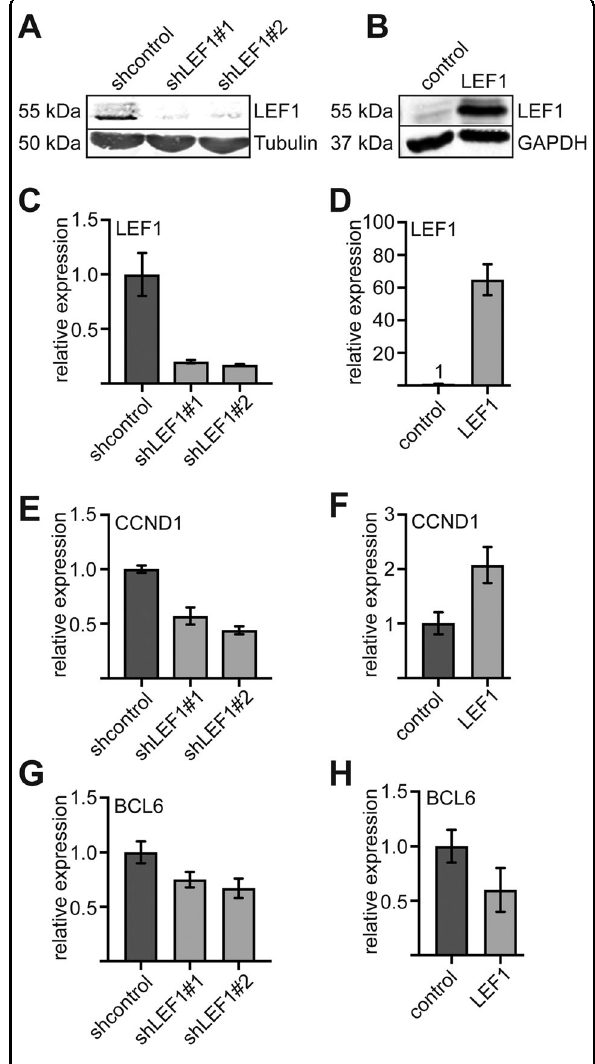
Fig. 5 LEF1 knockdown and over expression in K562 cells con fi rms in fl uence of LEF1 on CCND1 expression. A Western blot analysis of LEF1 knockdown in K562 cells. B Western blot analysis of LEF1 over expression in K562 cells. C mRNA level of LEF1 is decreased in LEF1 knockdown cells . D mRNA level of LEF1 is increased in LEF1 over expression cells. E CCND1 mRNA expression decreased after LEF1 knockdown. F mRNA level of CCND1 after LEF1 over expression in K562 cells. G BCL6 mRNA expression decreased after LEF1 knockdown. H mRNA level of BCL6 after LEF1 over expression in K562 cells. Error bars represent the standard deviation from the mean from at least three independent determinations. The P -values were calculated using Student ’ s t -test. * P < 0.05; ** P < 0.01; *** P <